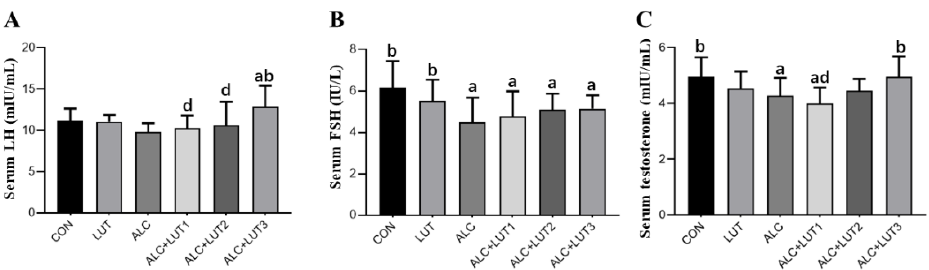
Figure 4. Male reproductive hormone levels. ( A ) Luteinizing (LH) hormone levels; ( B ) Follicle-stim- ulating hormone (FSH) levels; ( C ) Testosterone levels; CON: control group; LUT: lutein alone sup- plement group; ALC: alcohol model group; ALC + LUT1: alcohol + low-dose lutein group; ALC +